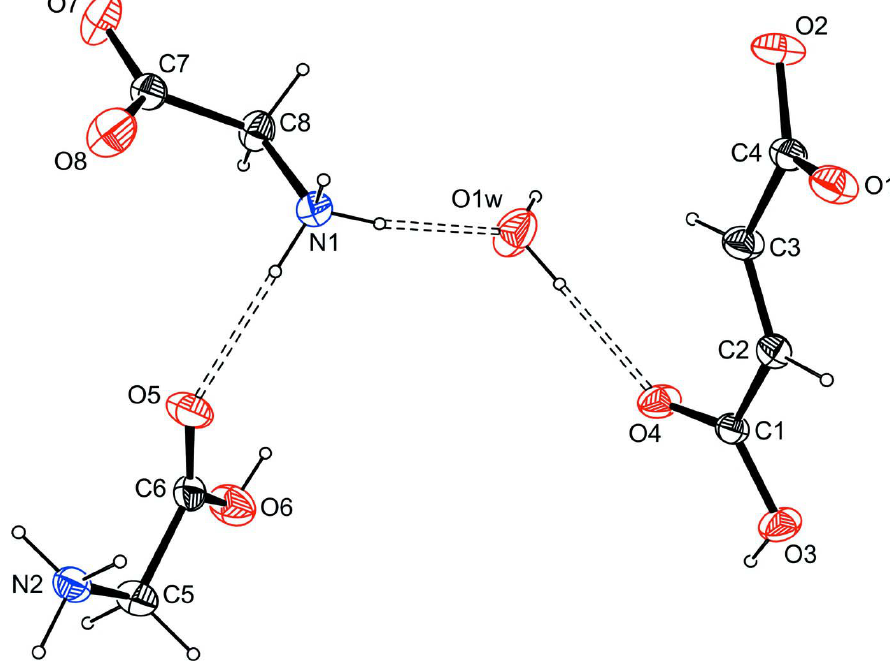
Figure 1 The molecular structure of (I), with the atom-labeling scheme. Displacement ellipsoids are drawn at the 30% probability level. H atoms are represented as small spheres of arbitrary radii. H bonds are shown as dashed